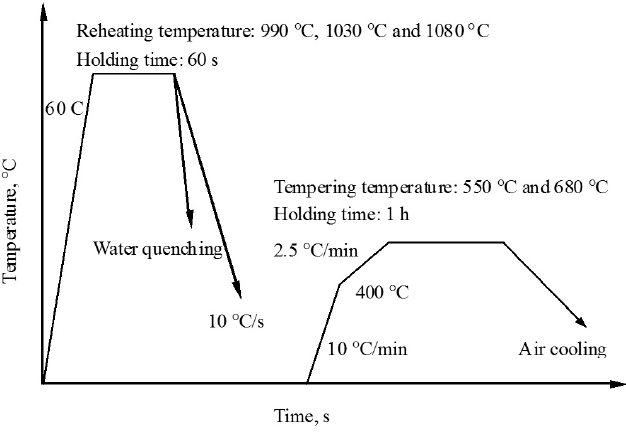
Figure 2. Schematic illustration of post ‐ weld heat treatment schedule for experimental weld metal.